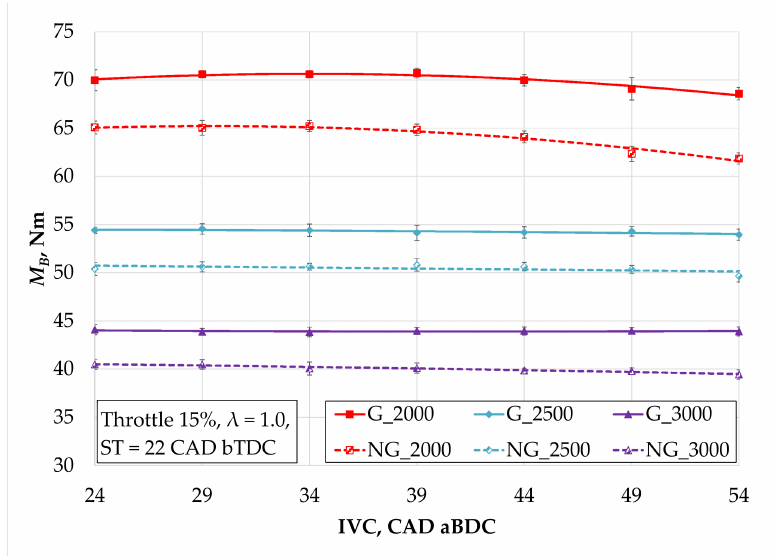
Figure 2. Brake torque when running on gasoline and natural gas and changing intake valve close